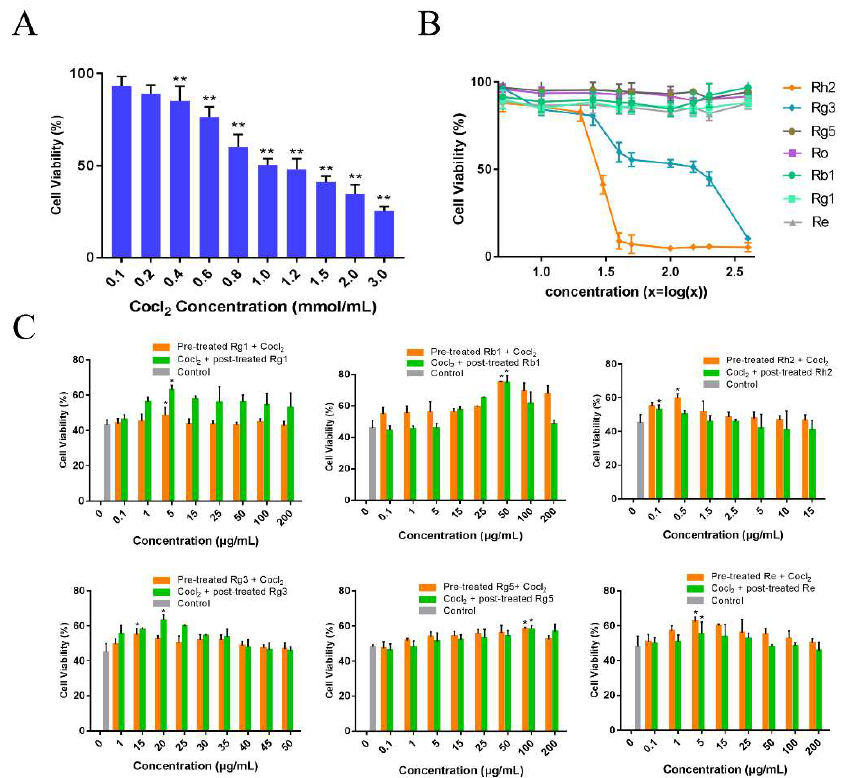
Figure 2. Protective effects of ginsenosides in CoCl 2 injured PC12 cells. ( A ) Effect of CoCl 2 on the cell viability of PC12 cells. The cells were induced with different concentration of CoCl 2 for 24 h. Each value represents the mean ± SD, from six independent experiments ( n = 6, ** mean p < 0.01 vs. control group); ( B ) Effect of ginsenoside Rg1, Rb1, Rh2, Rg3, Rg5 and Re (5, 10, 25, 40, 50, 100, 150, 200, 400 µ g/mL) on PC12 cells cytotoxicity ( n = 6). ( C ) The viability of PC12 cells pretreated with various concentrations of ginsenosides for 1 h before induced by CoCl 2 or treated with ginsenosides after induced by CoCl 2 for 1 h. The data are expressed as means ± SD ( n = 6). * p < 0.05, compared with the control.